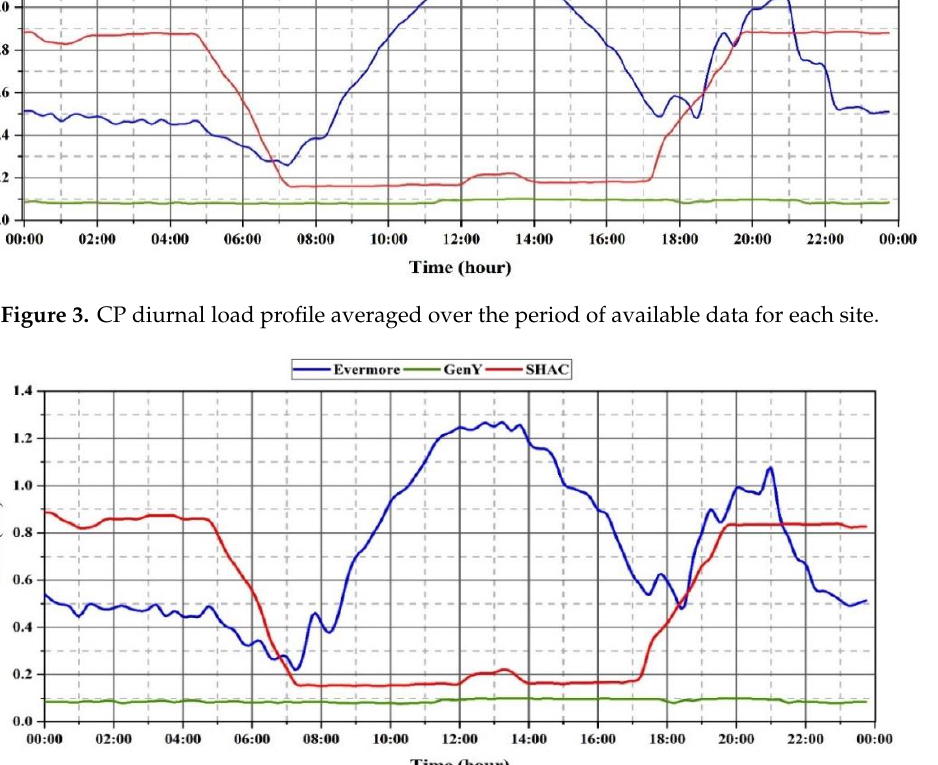
Figure 4. CP diurnal weekend load profile averaged over the period of available data for each